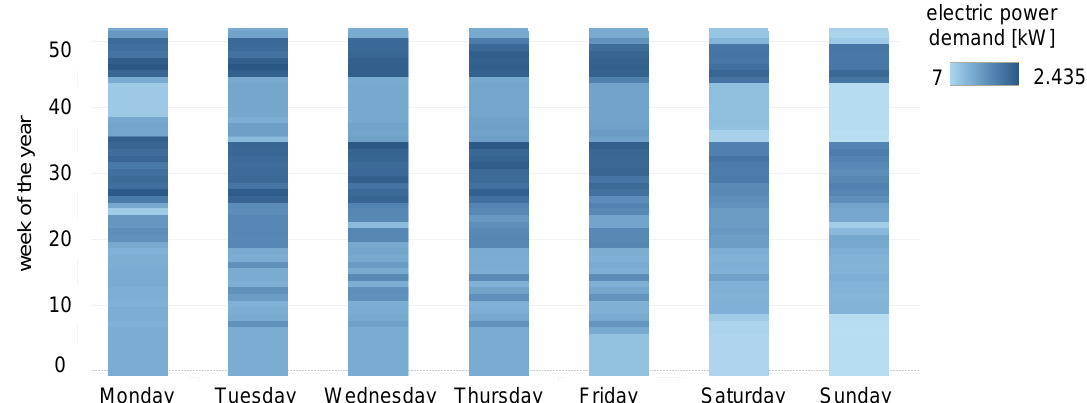
Figure 6. Heatmap of weekly electric power demand for one year, classified by weekdays.